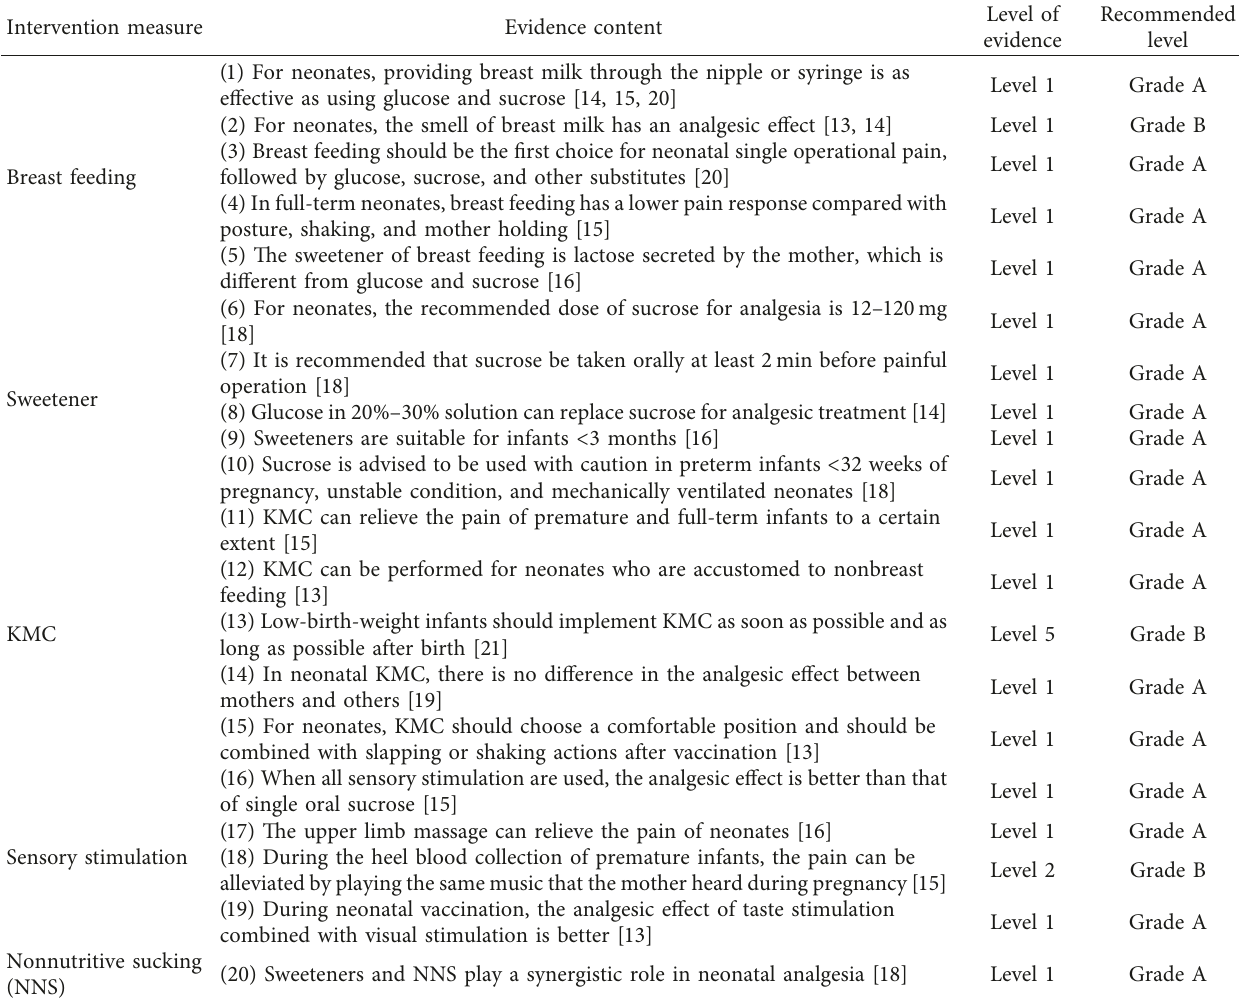
Table 4: Evidence description and